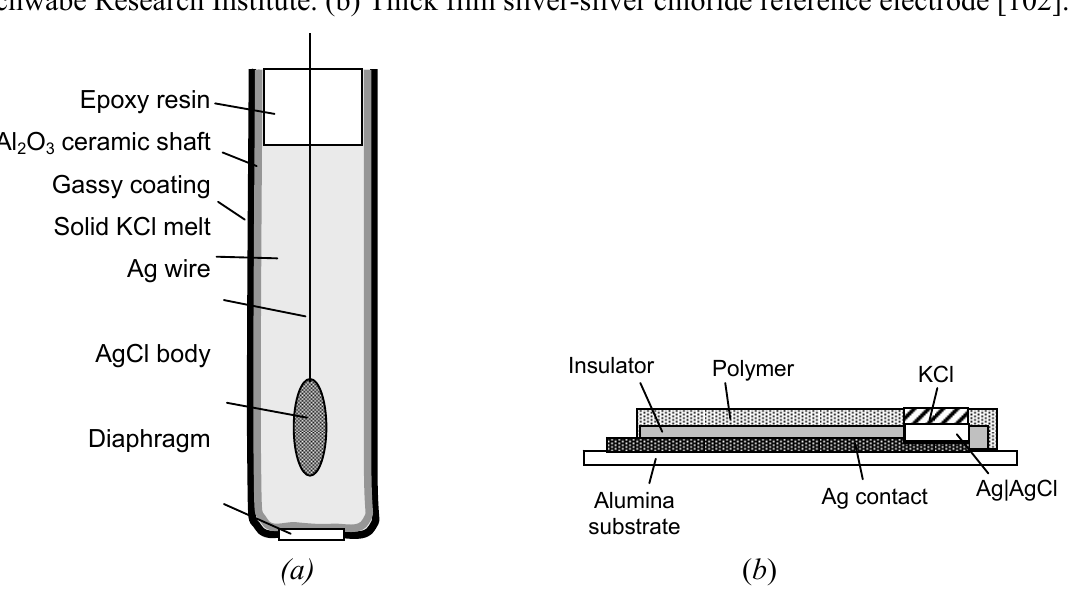
Figure 7. (a) Principle of an all-solid-state reference electrode after Meinsberg Kurt- Schwabe Research Institute. (b) Thick film silver-silver chloride reference electrode